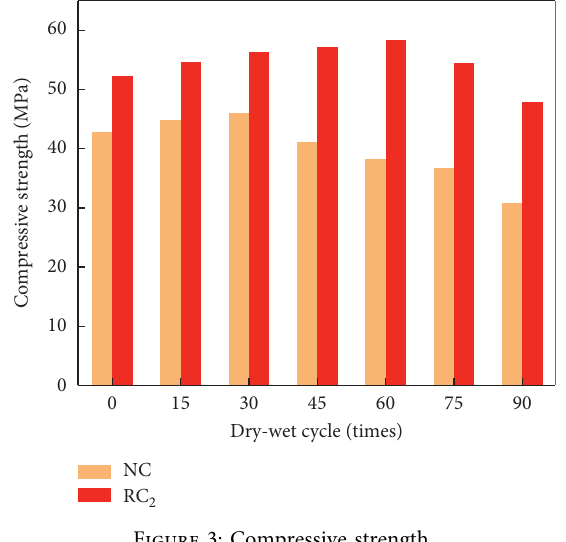
Figure 3: Compressive strength.